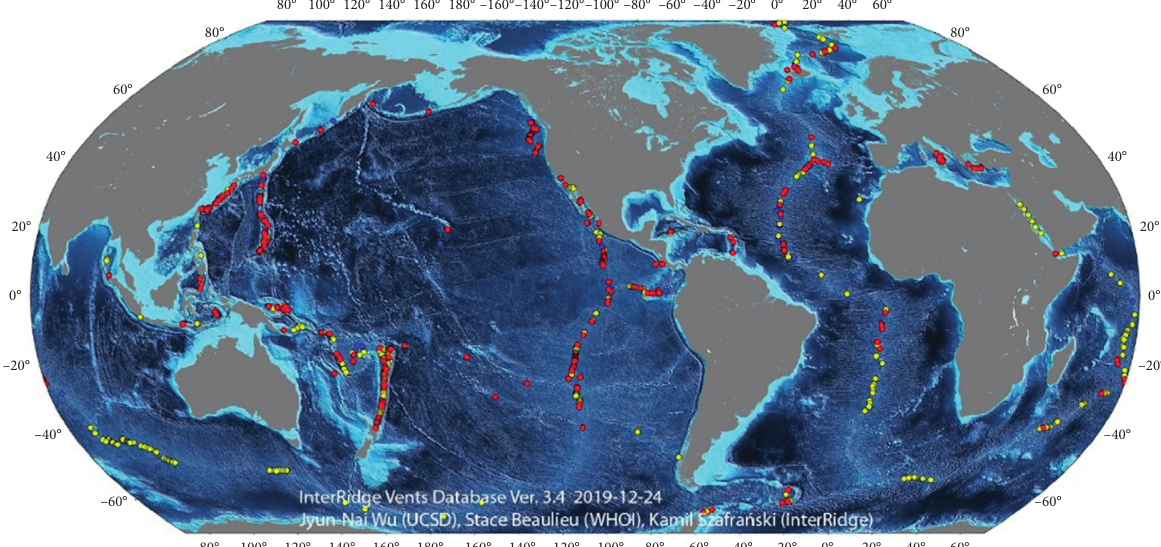
Figure 1: Distribution of hydrothermal activities globally (https://doi.org/10.1594/PANGAEA.917894).